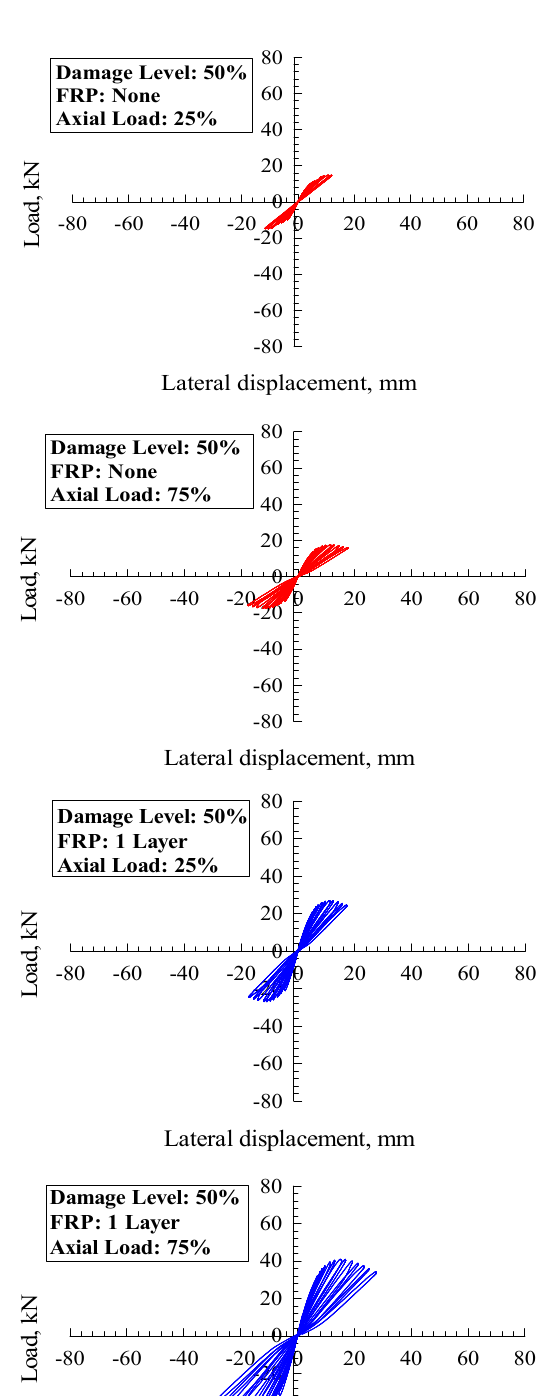
Figure 11. The load versus the lateral displacement envelopes.